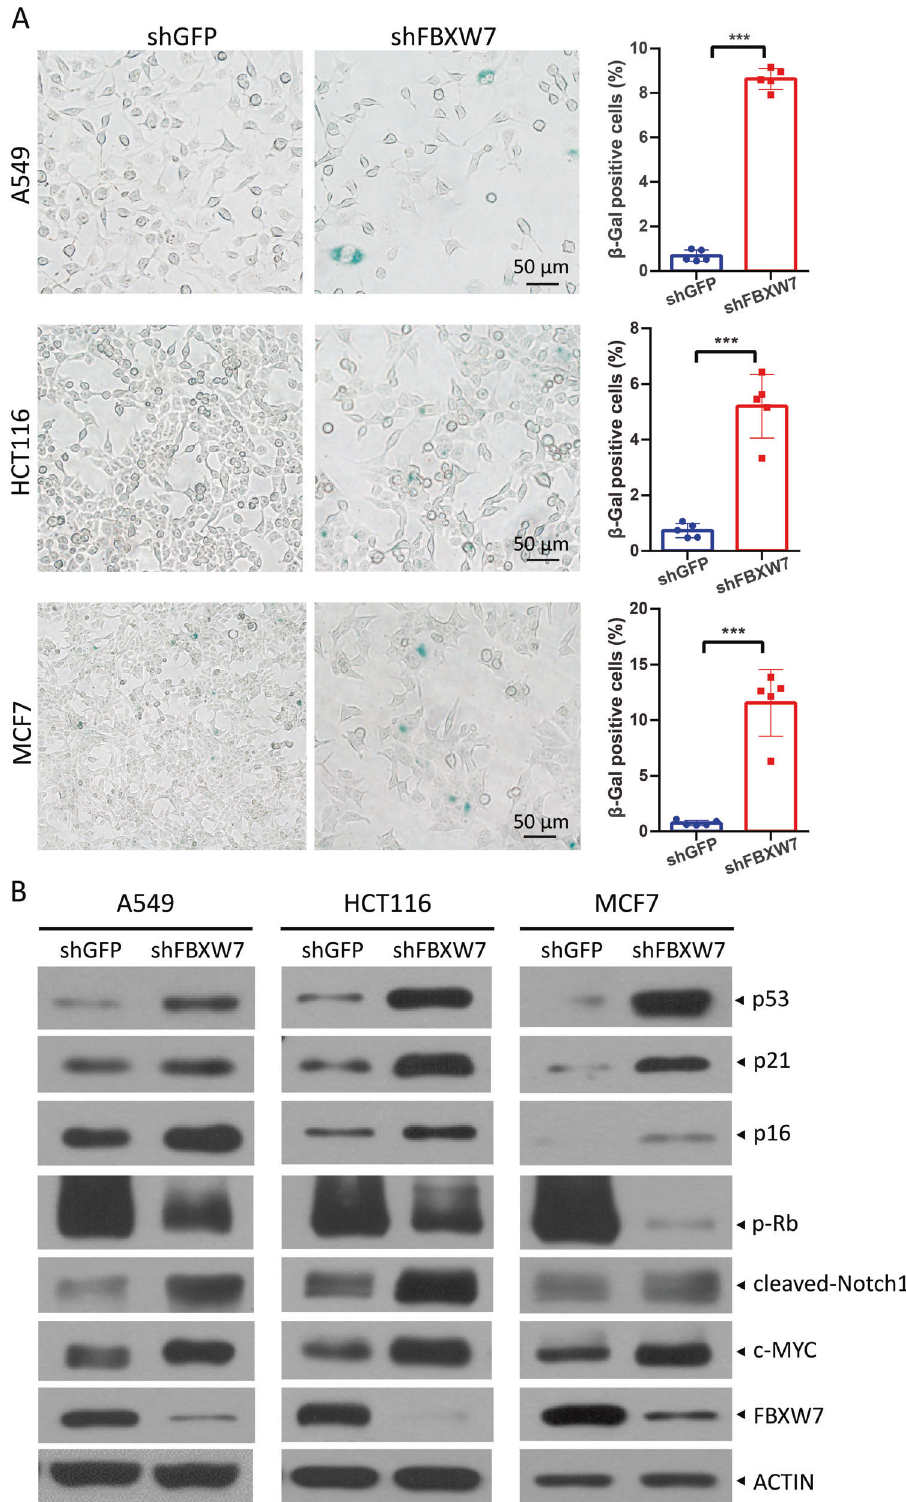
Fig. 1 FBXW7 silencing induces senescence in cancer cells harboring wild-type p53 along with activation of both p53/p21 and p16 INK4a / Rb pathways. A549, HCT116, and MCF7 cells were infected with a lentivirus expressing shFBXW7 or shGFP, selected by puromycin for seven days, and subjected to senescence-associated β -galactosidase (SA- β -Gal) staining, followed by microscopy ( A left) or immunoblotting (IB) with the indicated antibodies ( B ). The percentage of SA- β -Gal-positive cells in the total number of cells was determined ( A right). Scale bars represent 50 μ m. Data are presented as the mean ± standard deviation (SD). *** p < 0.001.